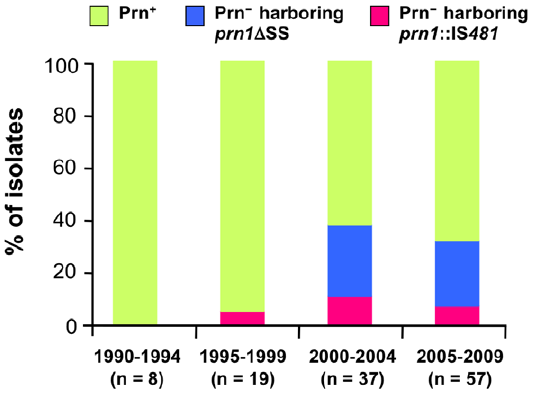
Figure 3. Temporal trend of the occurrence of Prn 2 isolates in Japan. The frequencies of Prn 2 isolates harboring prn1 D SS and prn1 ::IS 481 were based on 121 B. pertussis isolates collected during 1990–2009. Prn + indicates Prn-expressing isolate.